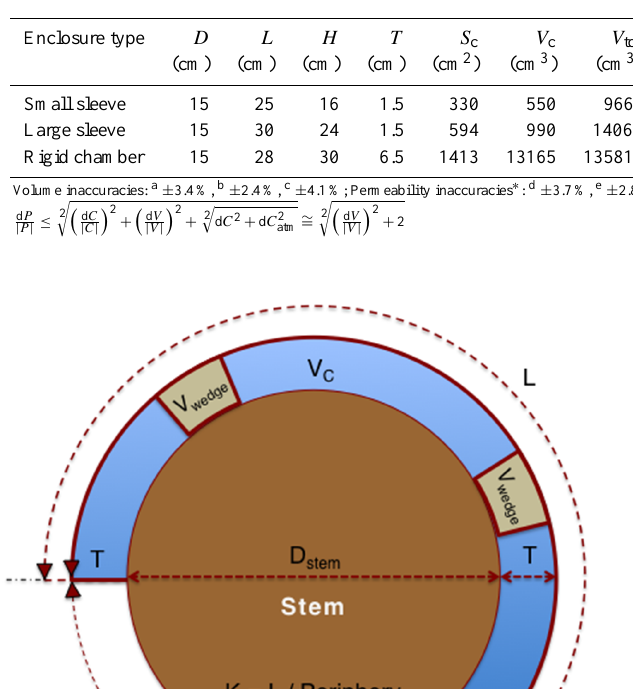
Table 1. Chamber dimensions and mean permeabilities ( P) determined, for each replicated chamber ( n = 3), from the methane decline slope (Slope), the total chamber volume ( V tot ) , the initial concentration gradient between outside and inside ( C 0 − C atm ) and the gas exchange surface ( S c ) . D = metallic cylinder diameter, L = peripherical length of the enclosure, H = height, T = thickness, C 0 = initial enclosure concentration, C atm = 1.8951ppmv, R 2 = coefficient of determination of the decline regression, V c = volume of the chamber, V tot = V c + V dead , V dead = dead volume of the analyser plus the tubes = 416cm 3 . Values in brackets represent the standard error of the mean ( ± SEM).